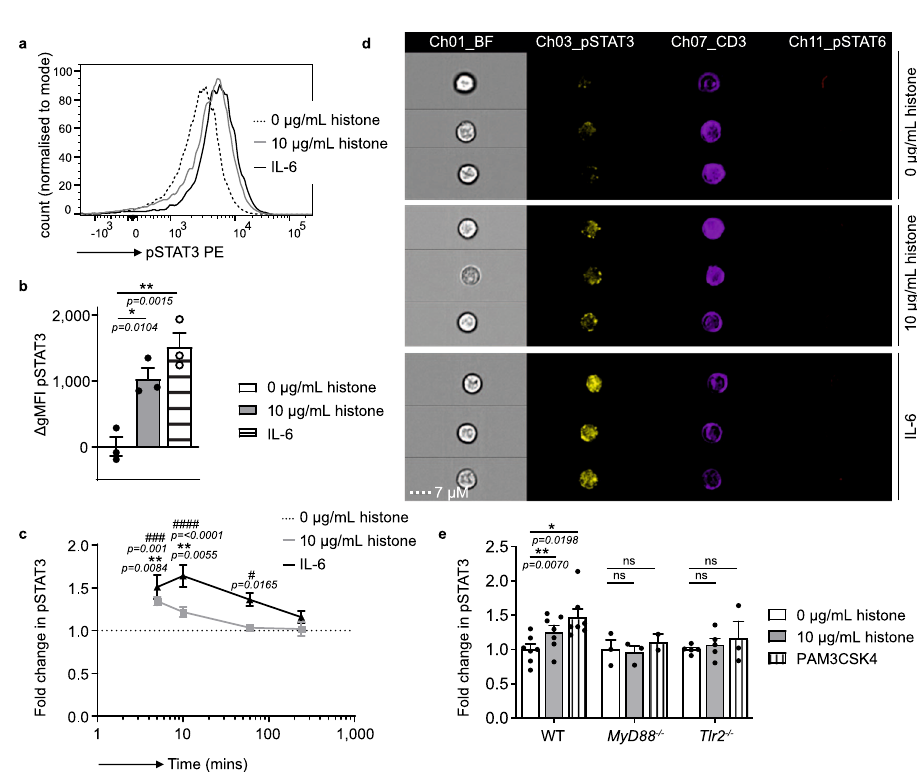
Fig. 6 Histones induce rapid phosphorylation of STAT3 in a MyD88-, TLR2-dependent manner. a Histogram showing the geometric mean of fl uorescence intensity (gMFI) and b quanti fi cation of the change in ( Δ ) the gMFI of tyrosine 705 phosphorylation of STAT3 (pSTAT3) after 5 min incubation with histones (10 µ g/mL, gray line) or IL-6 (black line) compared to controls (dashed black line) n = 3. c Relative gMFI of pSTAT3 compared to matched 0 µ g/mL control over time, n = 4 – 6 mice per time point. d Phosphorylation of STAT3 and STAT6 after 5 min of stimulation analyzed by imaging fl ow cytometry with images shown representative of the mean pSTAT3 fl uorescence intensity after stimulation. e Relative gMFI of treated cells from Myd88 − / − and Tlr2 − / − mice after 5 min n (WT) = 8, n ( My88 − / − , Tlr2 − / − ) = 3. Data bars show mean ± SEM. “ ns ” (not signi fi cant), p > 0.05; “ */ # ” p < 0.05; “ ** ” p < 0.01; “ ### ” p < 0.001; “ #### ” p < 0.0001. Where signi fi cance is not indicated, differences were ns. b One-way ANOVA with Dunnett ’ s multiple comparisons test, c mixed-effects model (REML) (where * denotes differences between 10 and 0 µ g/mL controls, # denotes signi fi cance between IL-6 and 0 µ g controls), e two-way ANOVA with Dunnet ’ s multiple comparisons test. All data are representative of a minimum of two independent experiments. Source data are provided as a Source Data fi fi ndings demonstrate that histones speci fi cally activate TLR2 on similar to cells treated with the canonical STAT3 inducer IL-6 (Fig. 6a – c). This fi nding was con fi rmed using imaging fl ow CD4 + T cells to promote activation and differentiation into cytometry (Fig. 6d and Supplementary Fig. 7). These effects were Th17 cells. not due to a generalized phosphorylation of STAT proteins, as STAT6 phosphorylation was not induced by histones or IL-6 Histone-TLR2 interactions induce STAT3 phosphorylation . To (Fig. 6d). understand how histones promote the induction of the Th17 cell- Most importantly, histones failed to induce STAT3 phosphor- speci fi c transcription factor ROR γ t, described previously ylation in the absence of MyD88 or TLR2 (Fig. 6e) further (Fig. 3d – f), we examined phosphorylation of the key signaling implicating histone engagement of TLR2 in driving Th17 cell transducer STAT3. The phosphorylation of STAT3 is a mod- responses. Additionally, the rapid phosphorylation of STAT3 i fi cation that is essential for Th17 cell formation and ROR γ t after the addition of histones further emphasizes the direct link expression 35 . After a fi ve-minute stimulation, naive T cells between histone binding and STAT3 phosphorylation. These data exposed to histones had increased phosphorylation of STAT3,